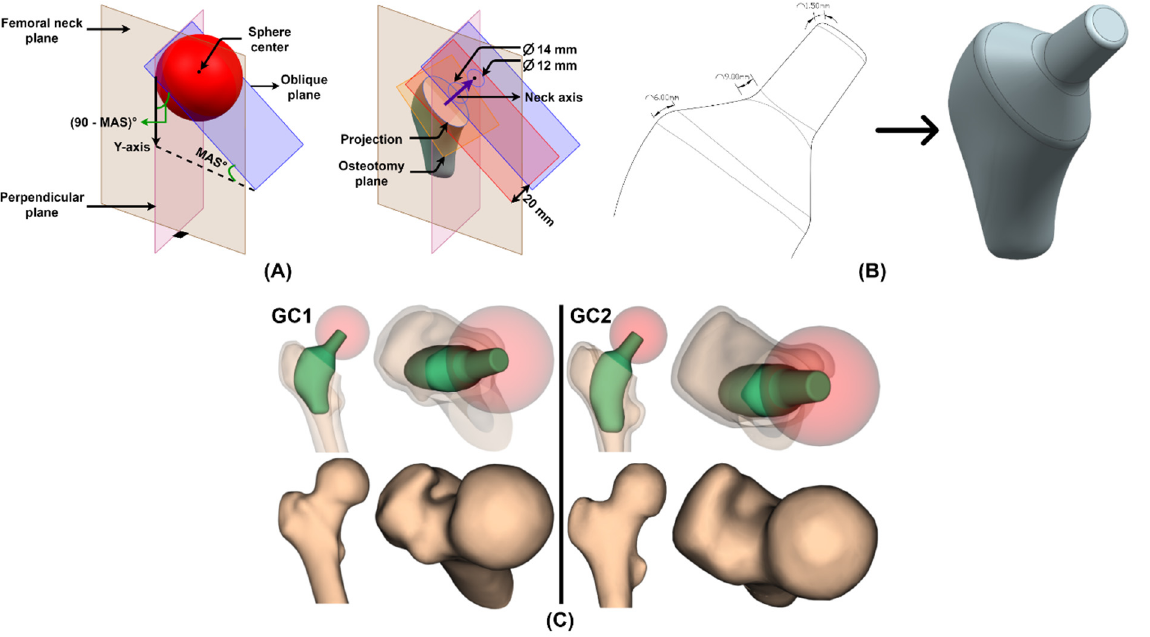
Figure 9. Neck and receiving taper ( A ) sketches and ( B ) solid. ( C ) Comparison between implanted and intact femur for GC1 and